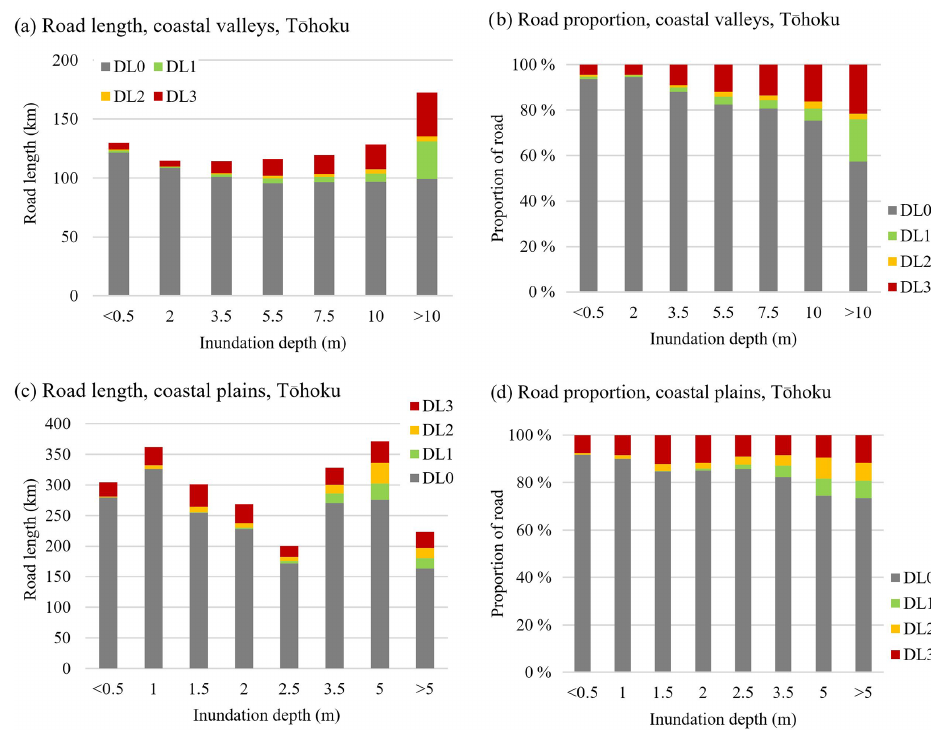
Figure 12. Total length (a) and proportion (b) of exposed roads in a coastal-valley topographic setting and total length (c) and proportion (d) of exposed roads in a coastal-plain topographic setting, by inundation depth, for the 2011 T¯ohoku earthquake and tsunami.